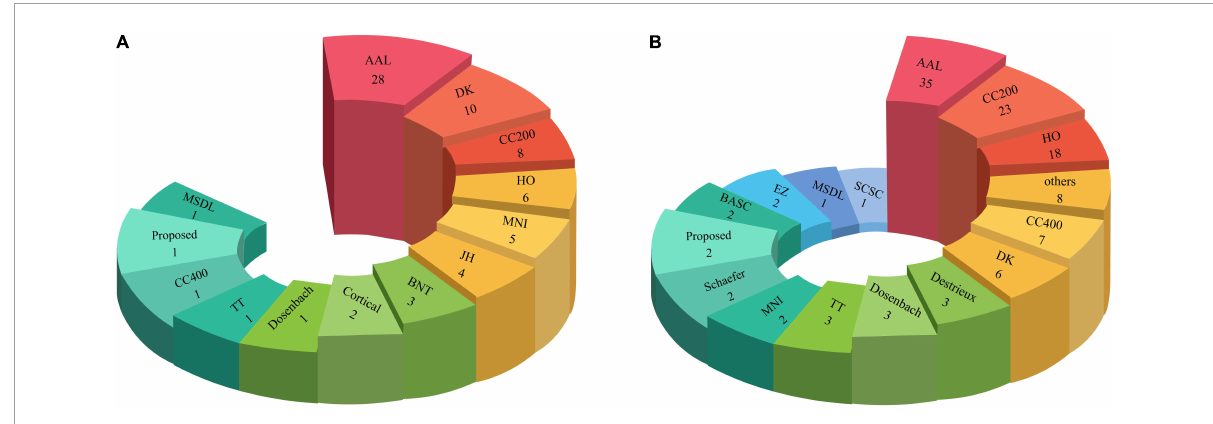
FIGURE7 Number of Atlas used for ASD detection. (A) ML and (B) DL methods.